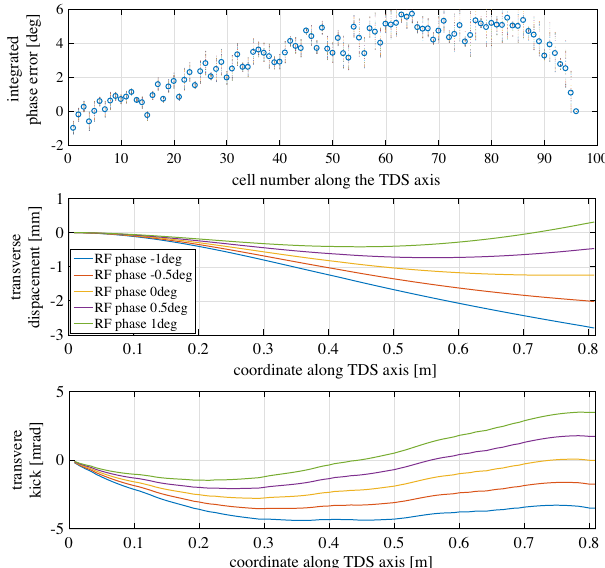
FIG. 28. Integrated phase errors as a function of the cell number along the TDS (top). Effects of the phase advance errors on the transverse displacement of the centroid (middle) and on the transverse kick (bottom) along the TDS and for different rf phases. FIG. 29. The PolariX TDS installed in the XBOX2 test